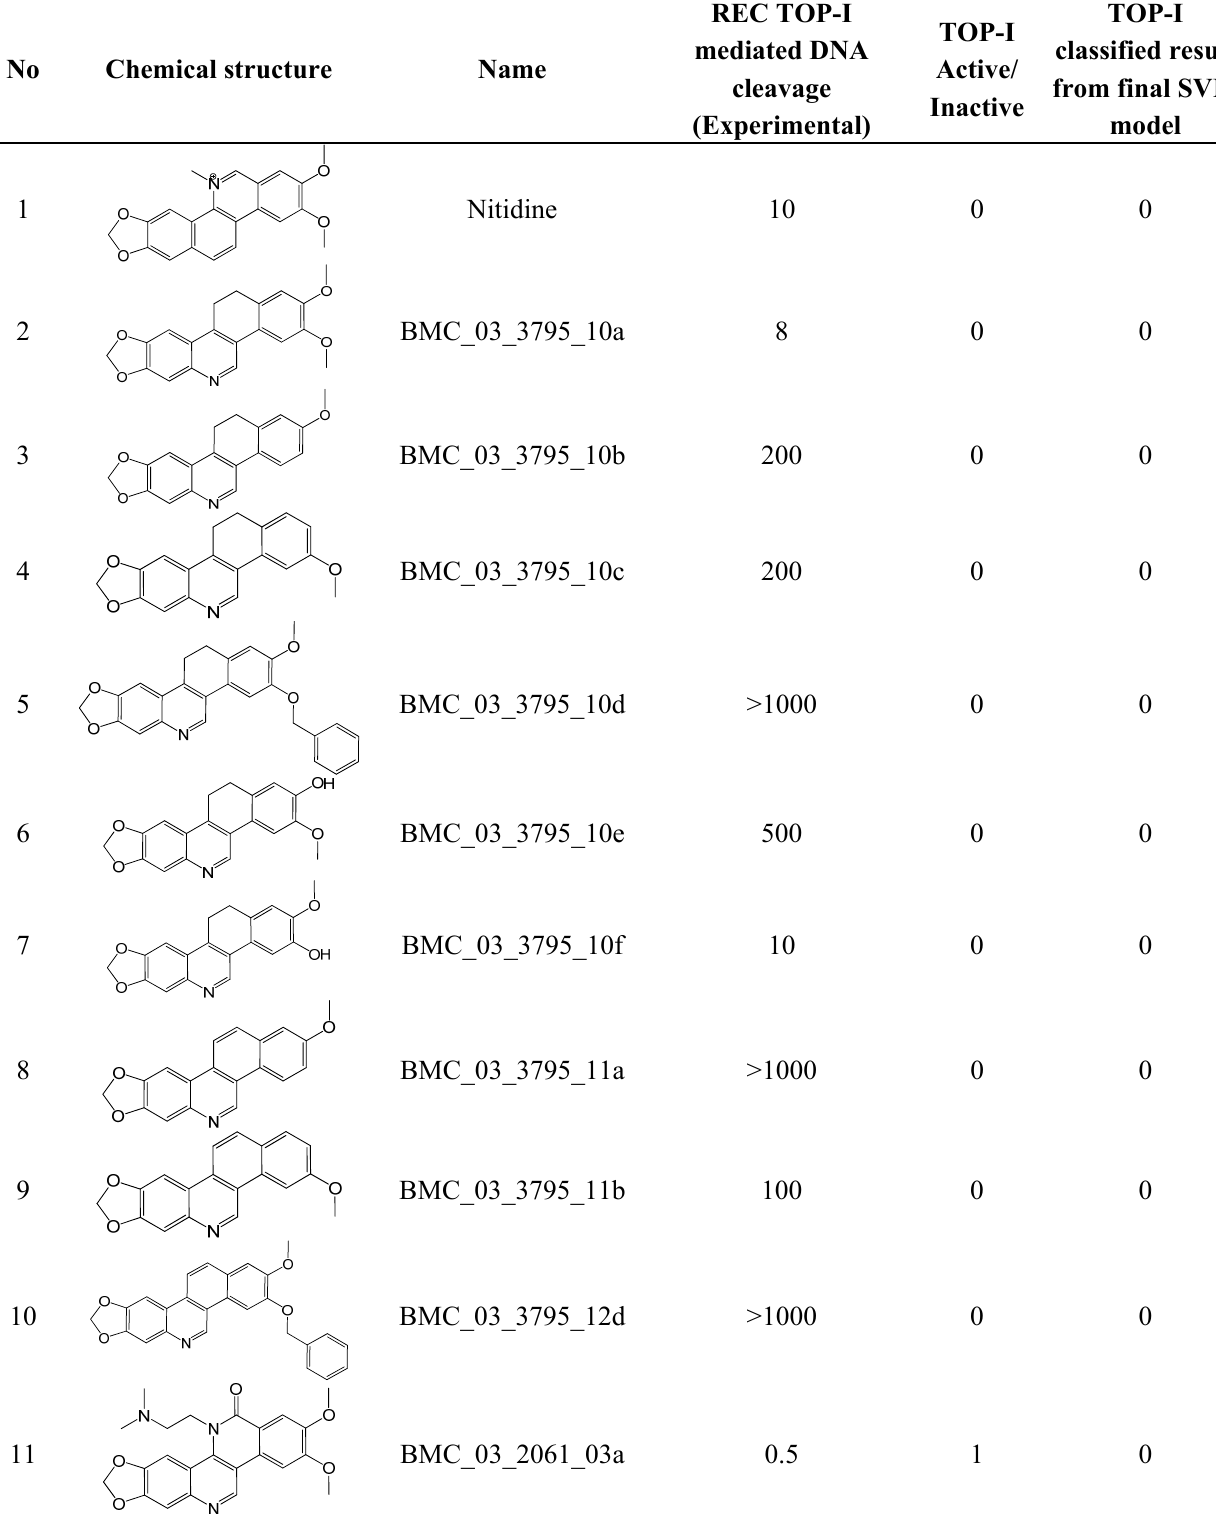
Table 6. Chemical structure of 82 benzo[ c ]phenanthridine derivatives and their topoisomerase I inhibitory activity REC and classification results from final SVM model. Classification term: “1” presented TOP-I active compound having equal or stronger activity than that of topotecan; “0” presented TOP-I inactive compound having weaker activity than that of